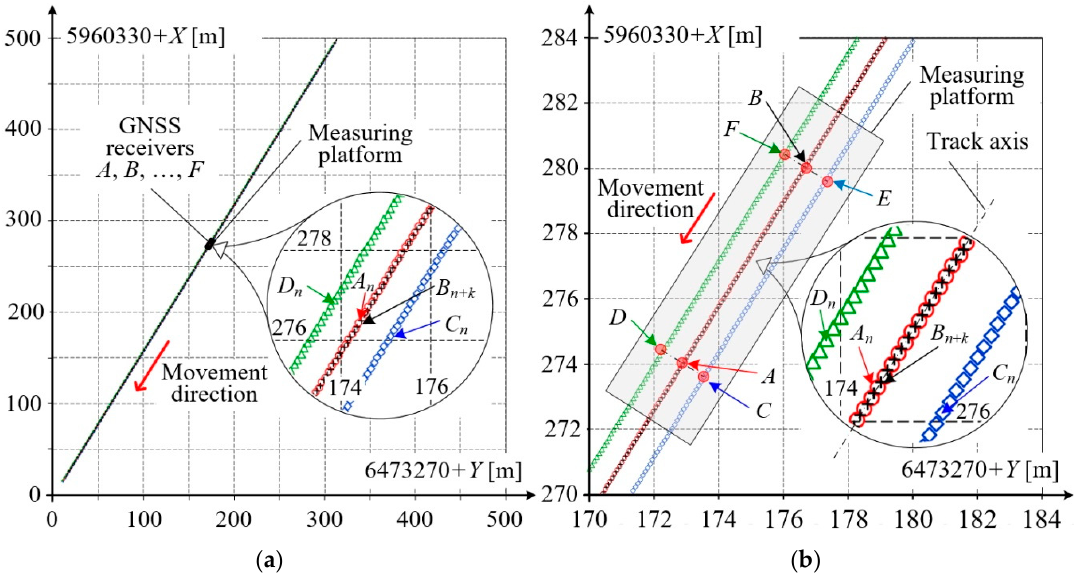
Figure 7. Results acquired by multi GNSS platform: ( a ) for longer section on straight railway track; ( b ) in expanded scale for receivers A , B , C and D .